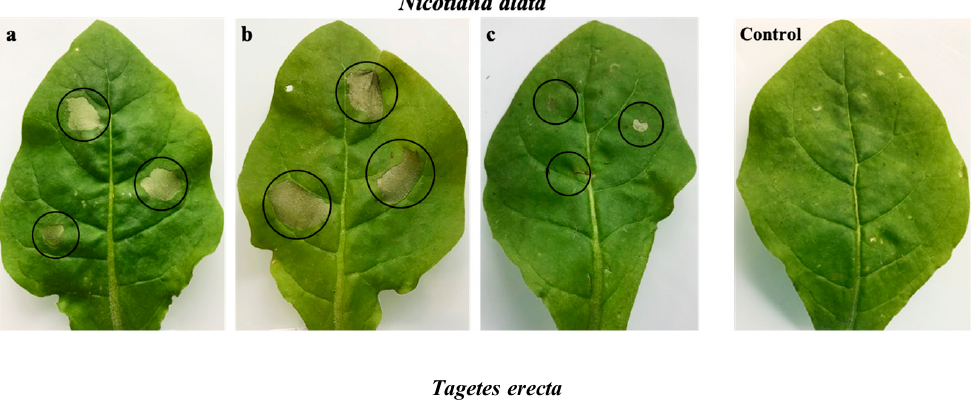
Figure 3. Leaf immersion assay. Phytotoxic damage of α -acetylorcinol ( 1 ) and p -hydroxybenzoic acid ( 2 ) on leaves excised from parsnip ( P. sativa ) and parsley ( P. crispum ) plants: ( a ) p -hydroxybenzoic acid (7.25 mM), ( b ) p -hydroxybenzoic acid (14.5 mM), ( c ) p -hydroxybenzoic acid (22.0 mM), ( d ) α - acetylorcinol (22.0 mM), ( e ) p -hydroxybenzoic acid (14.5 mM), ( f ) p -hydroxybenzoic acid (22.0 mM), and ( g ) α -acetylorcinol (22.0 mM). The sterile uninoculated medium was used as a control. The circle indicates the phytotoxic effect.